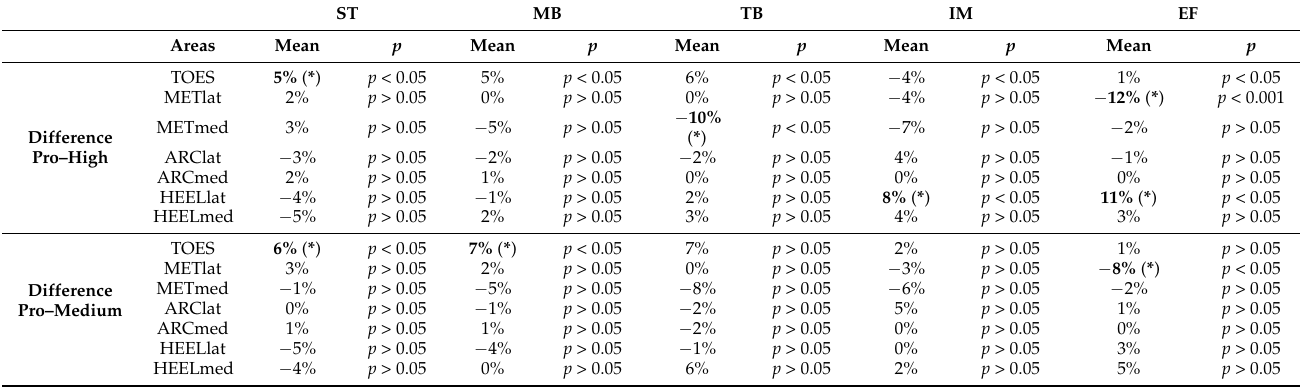
Table 2. Differences in the means of the normalized pressures in the left foot (lead) between Profes- sionals and High handicap players (Difference Pro–High) and Professionals versus Medium handicap players (Difference Pro–Medium) at the key time instants (ST (Stand), MB (middle backswing), TB (top backswing), IM (Impact), EF (early finish)) in the seven previously defined areas (Toes (all toes), METlat (lateral metatarsal), METmed (medial metatarsal), ARClat (lateral arch), ARCmed (medial arch) HEELlat (lateral heel), HEELmed (medial heel)). The * denotes a statistically significant difference between the compared groups (Professional vs. high or Professional vs. Medium) with significance level p < 0.05. ST MB